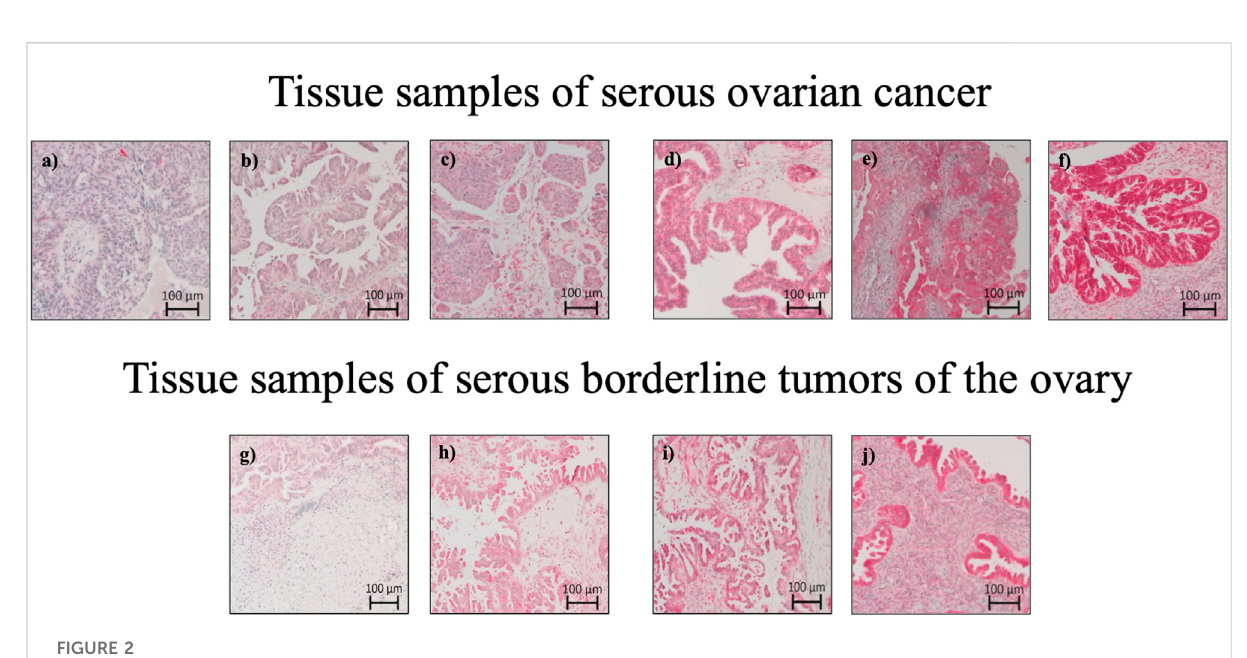
FIGURE 2 Sec62 immunohistochemistry stainings: Tissue samples ofserous ovarian cancer and serous borderlinetumors of the ovary. (A) Serous ovarian cancer with Sec62 immunoreactive score (IRS) 3, (B) serous ovarian cancer with Sec62 immunoreactive score (IRS)4, (C) serous ovariancancer with Sec62 immunoreactive score (IRS) 8, (D,E) serous ovarian cancer with Sec62 immunoreactive score (IRS) 9, (F) serous ovarian cancer with Sec62immunoreactivescore(IRS)12, (G) serousborderlinetumorsoftheovarywithSec62immunoreactivescore(IRS)4, (H) serousborderline tumors of theovary with Sec62 immunoreactive score (IRS)6, (I) serous borderline tumors oftheovarywith Sec62immunoreactive score (IRS)8, (J) serous borderline tumors of the ovary with Sec62 immunoreactive score (IRS)